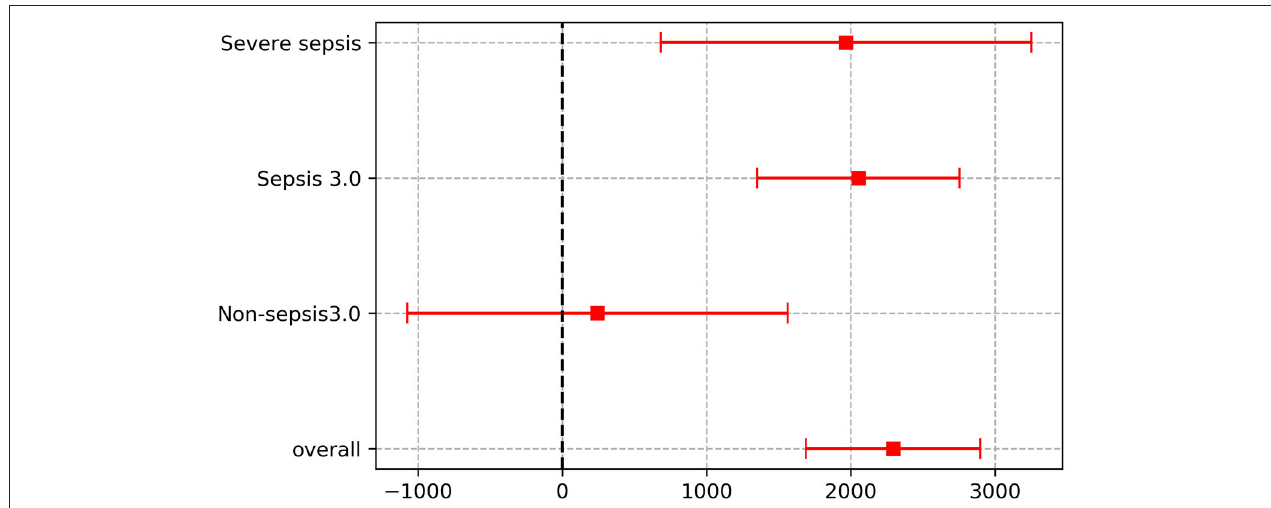
FIGURE 3 | Distribution of each coefficients.